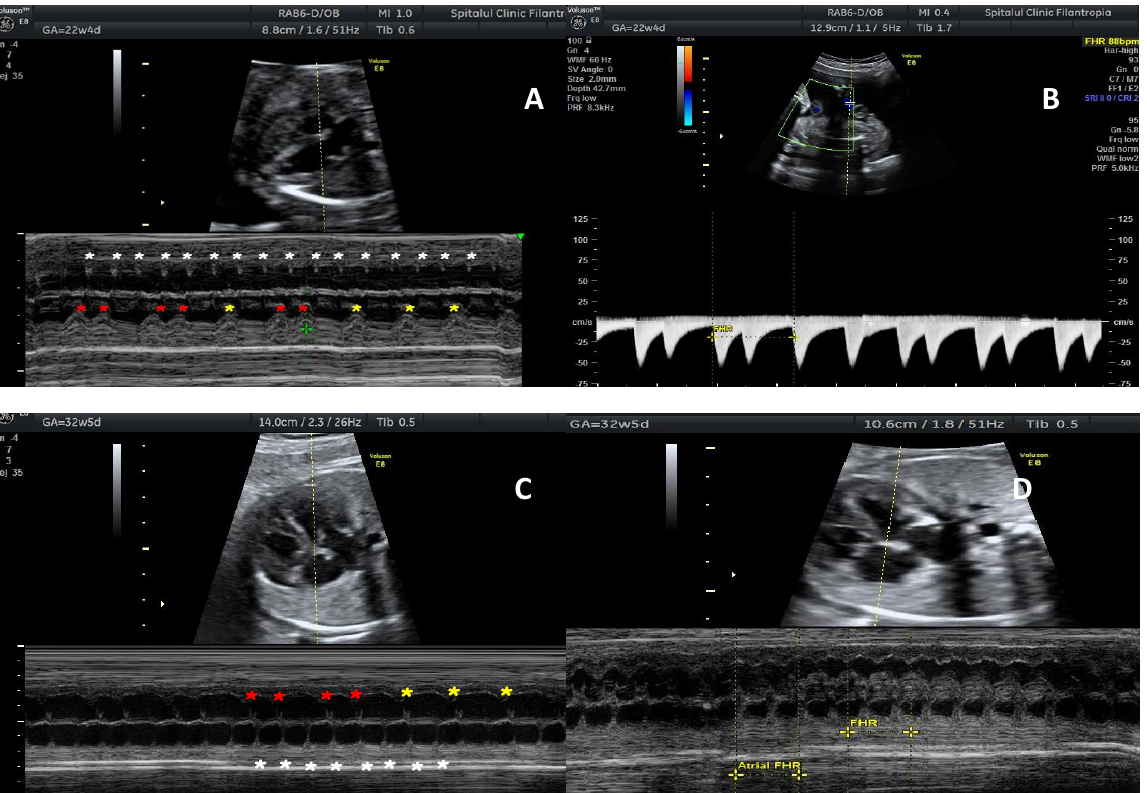
Figure 1. M-mode recording and dopler studies in a fetus with congenital heart block. ( A ) M-mode fetal echocardiography showing simultaneously atrial contractions (white stars) and ventricular contractions (red stars in 2nd degree block and yellow stars show complete dissociation in 3rd degree block). ( B ) Umbilical artery power Doppler evaluation shows an incomplete heart block, in inter- mittent 2nd degree block, heart rate of about 90 bpm. ( C , D ) M-mode recording 1:1 atrioventricular transmission and normal ventricular